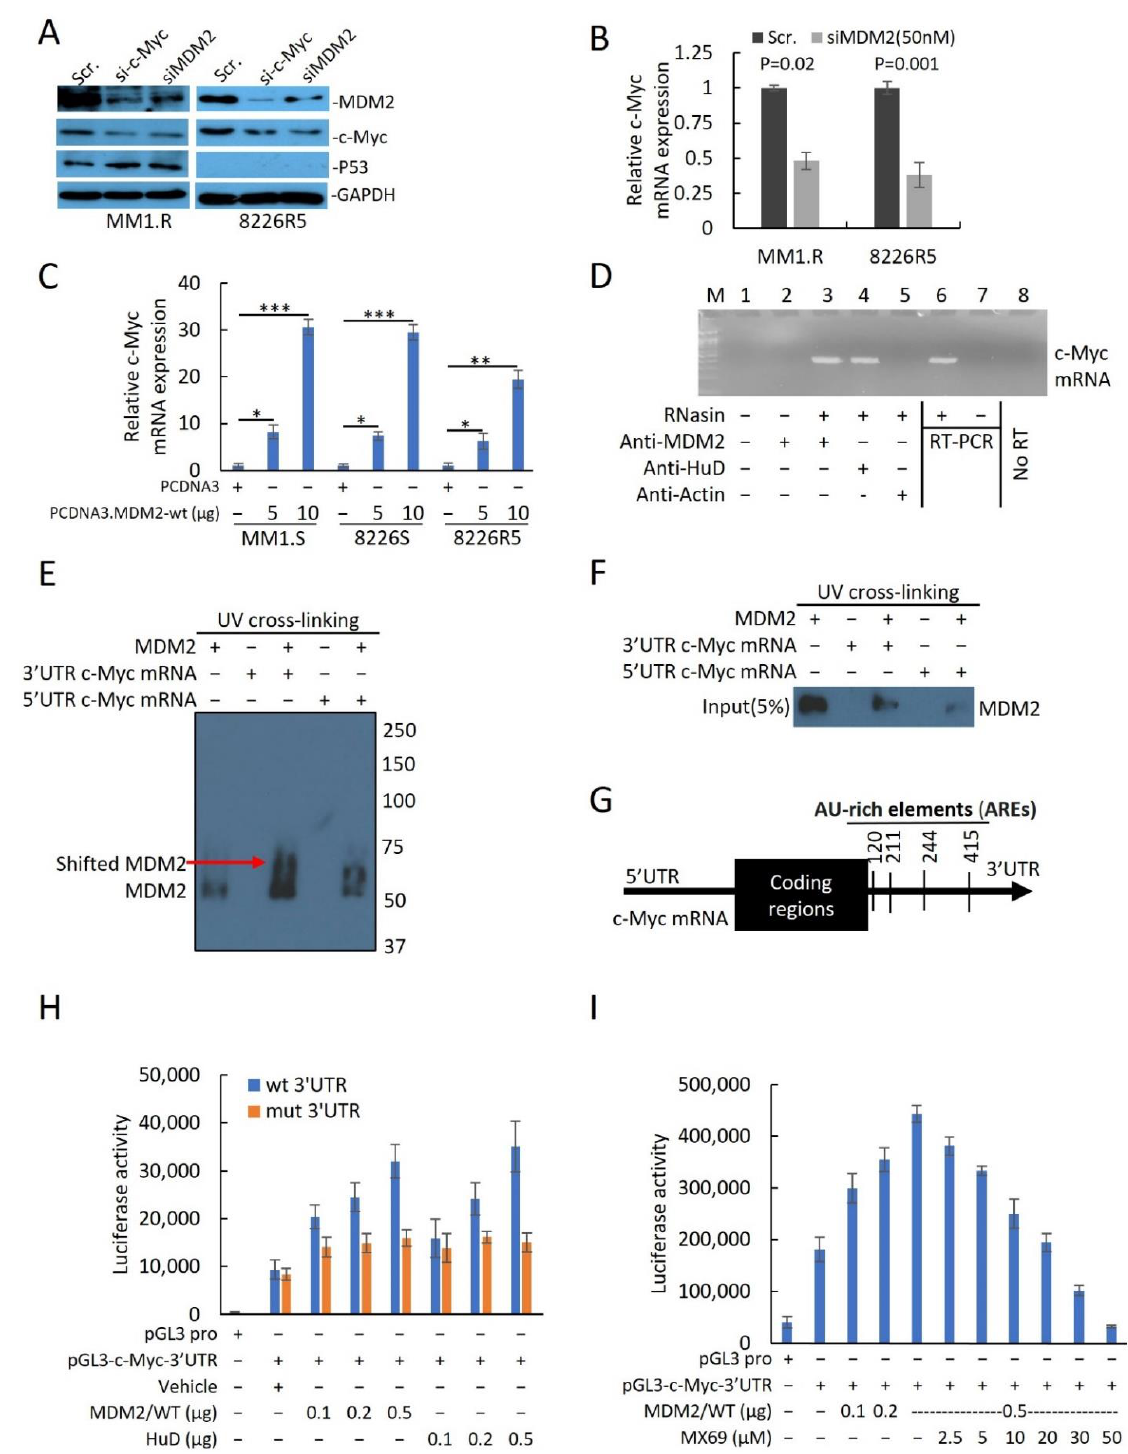
Figure 5. MDM2 directly regulates c-Myc mRNA stabilization and translation in MM cells. ( A ) West- ern blot of cell lysates from MM1.R and 8226R5 cells after 48 h transfection with si-MDM2 (50 nM) or si-c-Myc (50 nM). The uncropped blot is in Supplemental Figure S16. ( B ) Quantitative RT-PCR indicating the levels of c-Myc expression in 8226R5 cells after 48 h transfection with siMDM2 or control siRNA (Scr) with indicated concentrations. Results are presented as mean ± SD of three in- dependent experiments. ( C ) Quantitative RT-PCR indicating the levels of c-Myc mRNA in MM1.S, 8226S, and 8226R5 cells after transfection with MDM2-WT or control plasmid for 48 h. Results are